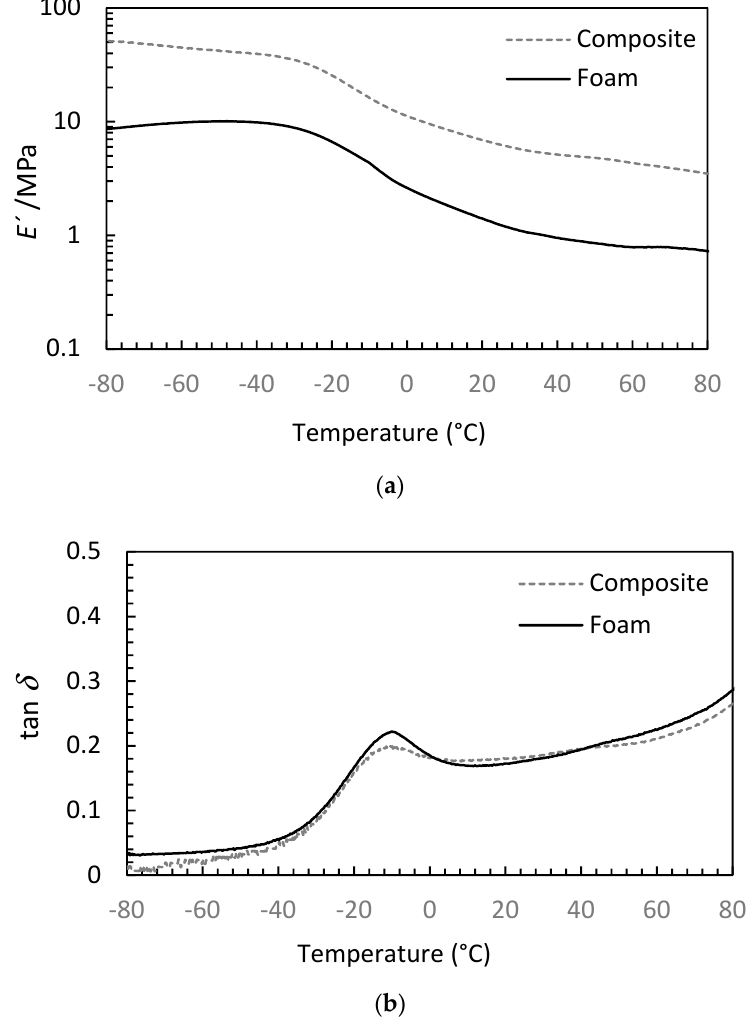
Figure 4. DMA results for composite coating with and 1:10 cork:resin mass ratio. ( a ): storage modulus, E’ ; ( b ): dissipation factor, tan δ .